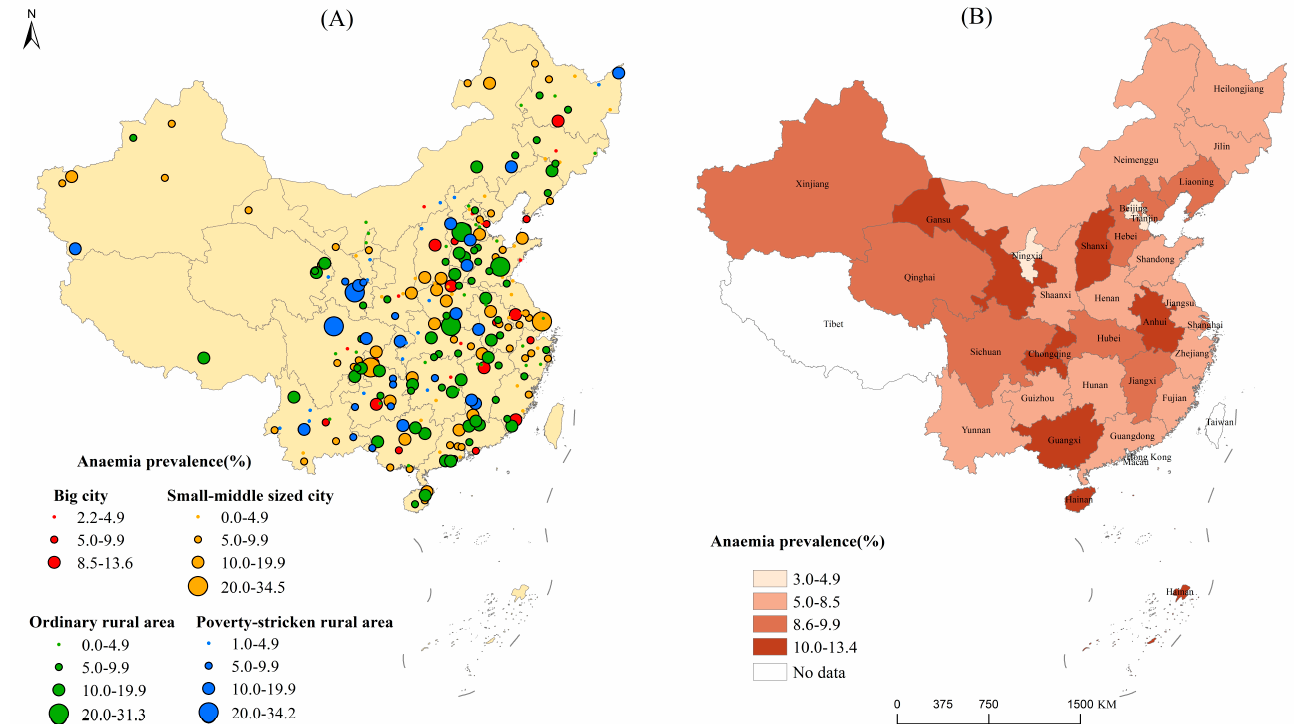
Figure 2. ( A ) Anemia prevalence in adolescent girls at surveillance-point level; ( B ) anemia prevalence in adolescent girls at provincial level.